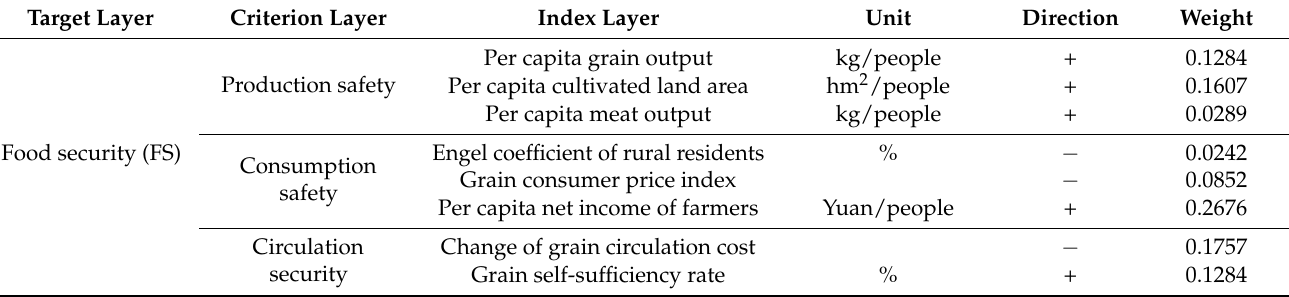
Table 2. Evaluation index system of